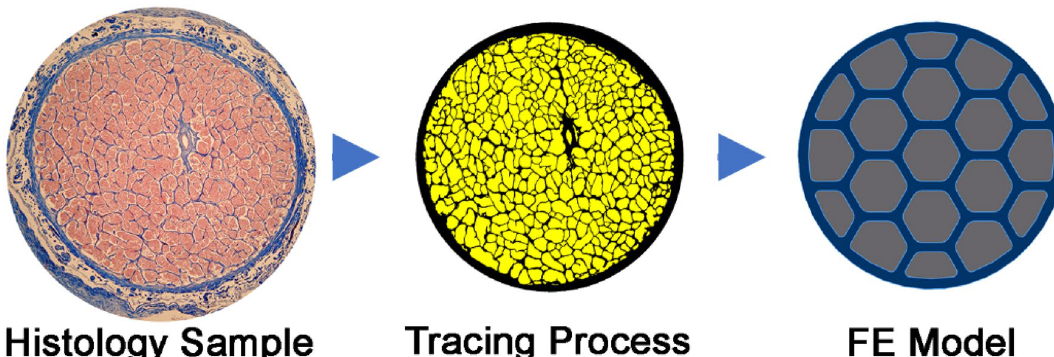
Figure 7. Model simplification of human optic nerve (ON). Transverse histological section of 57 year old human ON was chosen to calculate the proportion portion of connective versus neural tissue. In this 10 μm thick histological section stained with Mason trichrome at left, neural tissue (pink) was segmented from connective tissue (blue) as outlined as in the middle tracing. After assigning a 9:16 area ratio of connective to neural tissue, the ON was simplified as the honeycomb structure at right for